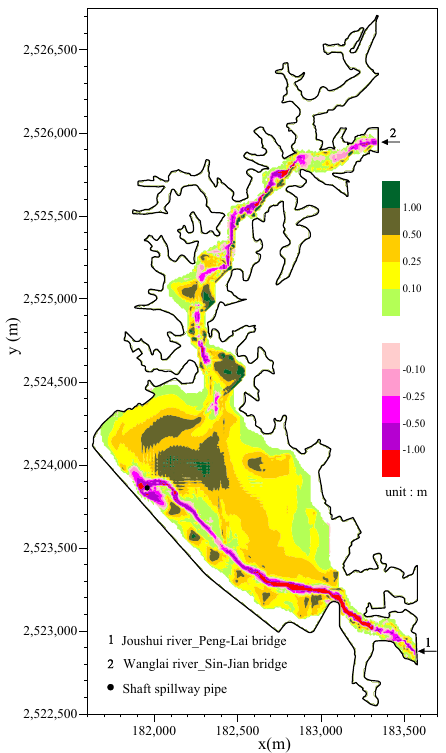
Figure 10. Bed evolution in the reservoir during a 25-year return period, t = 120 h.